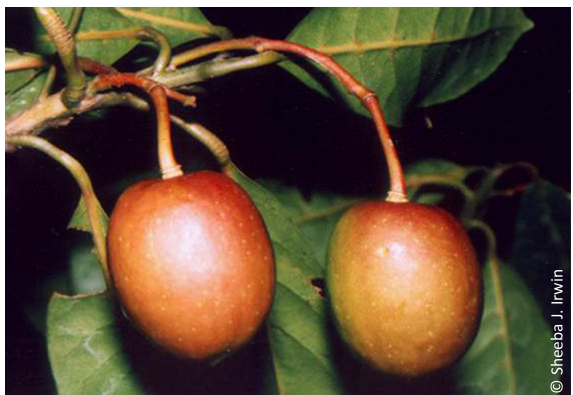
Image 2. Fruits of E. venustus